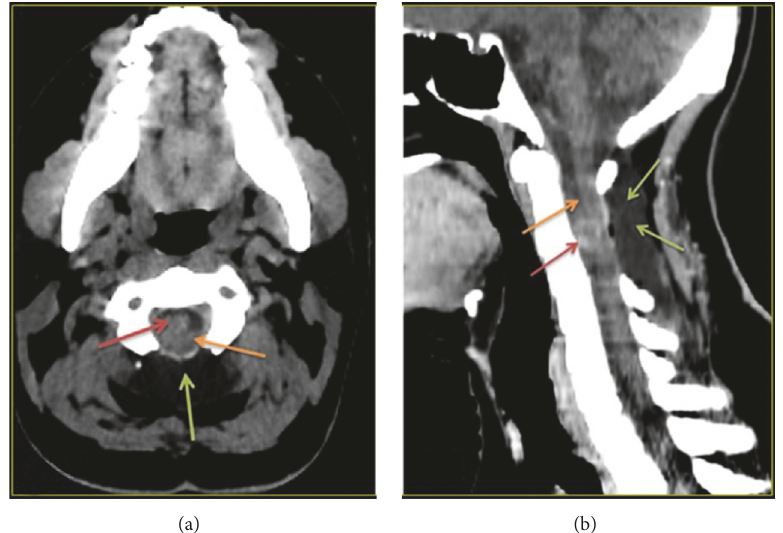
Figure 5: Axial NECT (Figure 5(a)) and sagittal NECT (Figure 5(b)) of cervical spine demonstrate surgical changes secondary to posterior spinal decompression (green arrows) at C2 and C3 levels, as well as a well-defined soft tissue density lesion (red arrows) anterior to cervical spinal cord (orange arrows) at C2-C3.